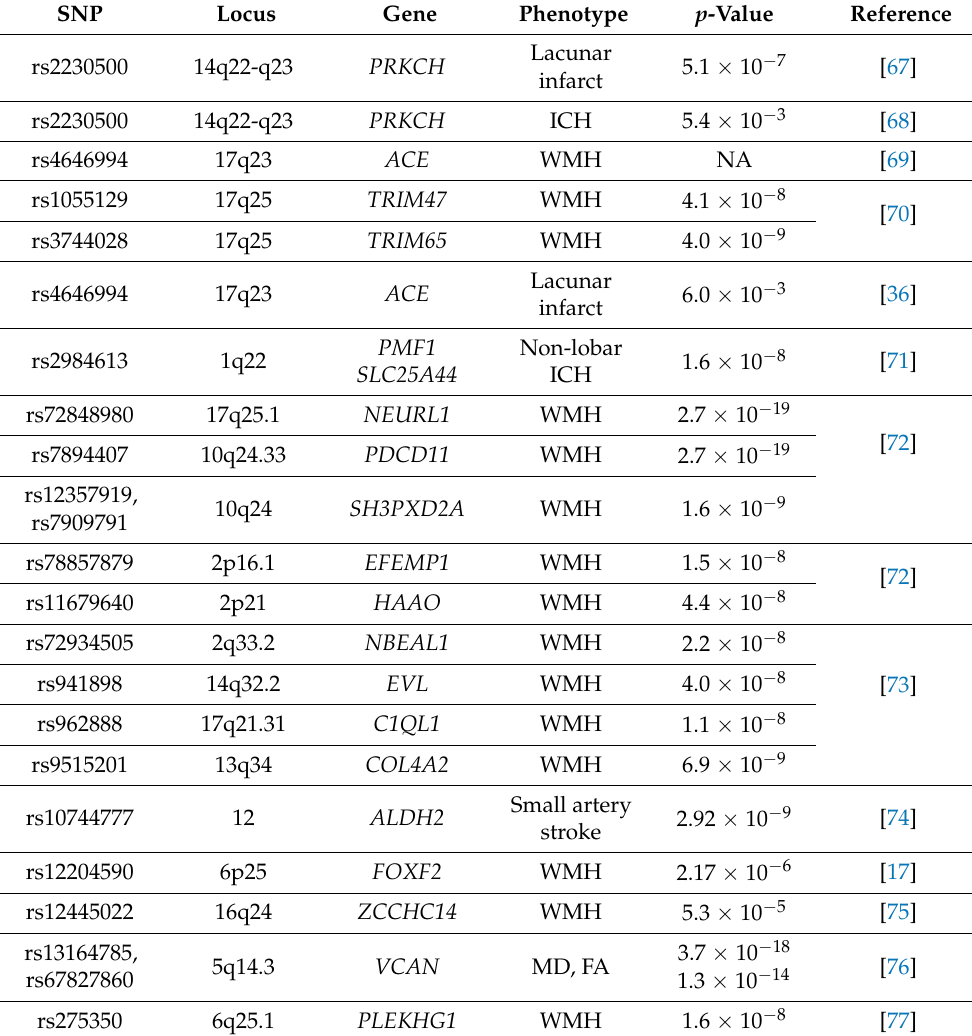
Table 1. CSVD-associated SNPs identified in genome-wide association